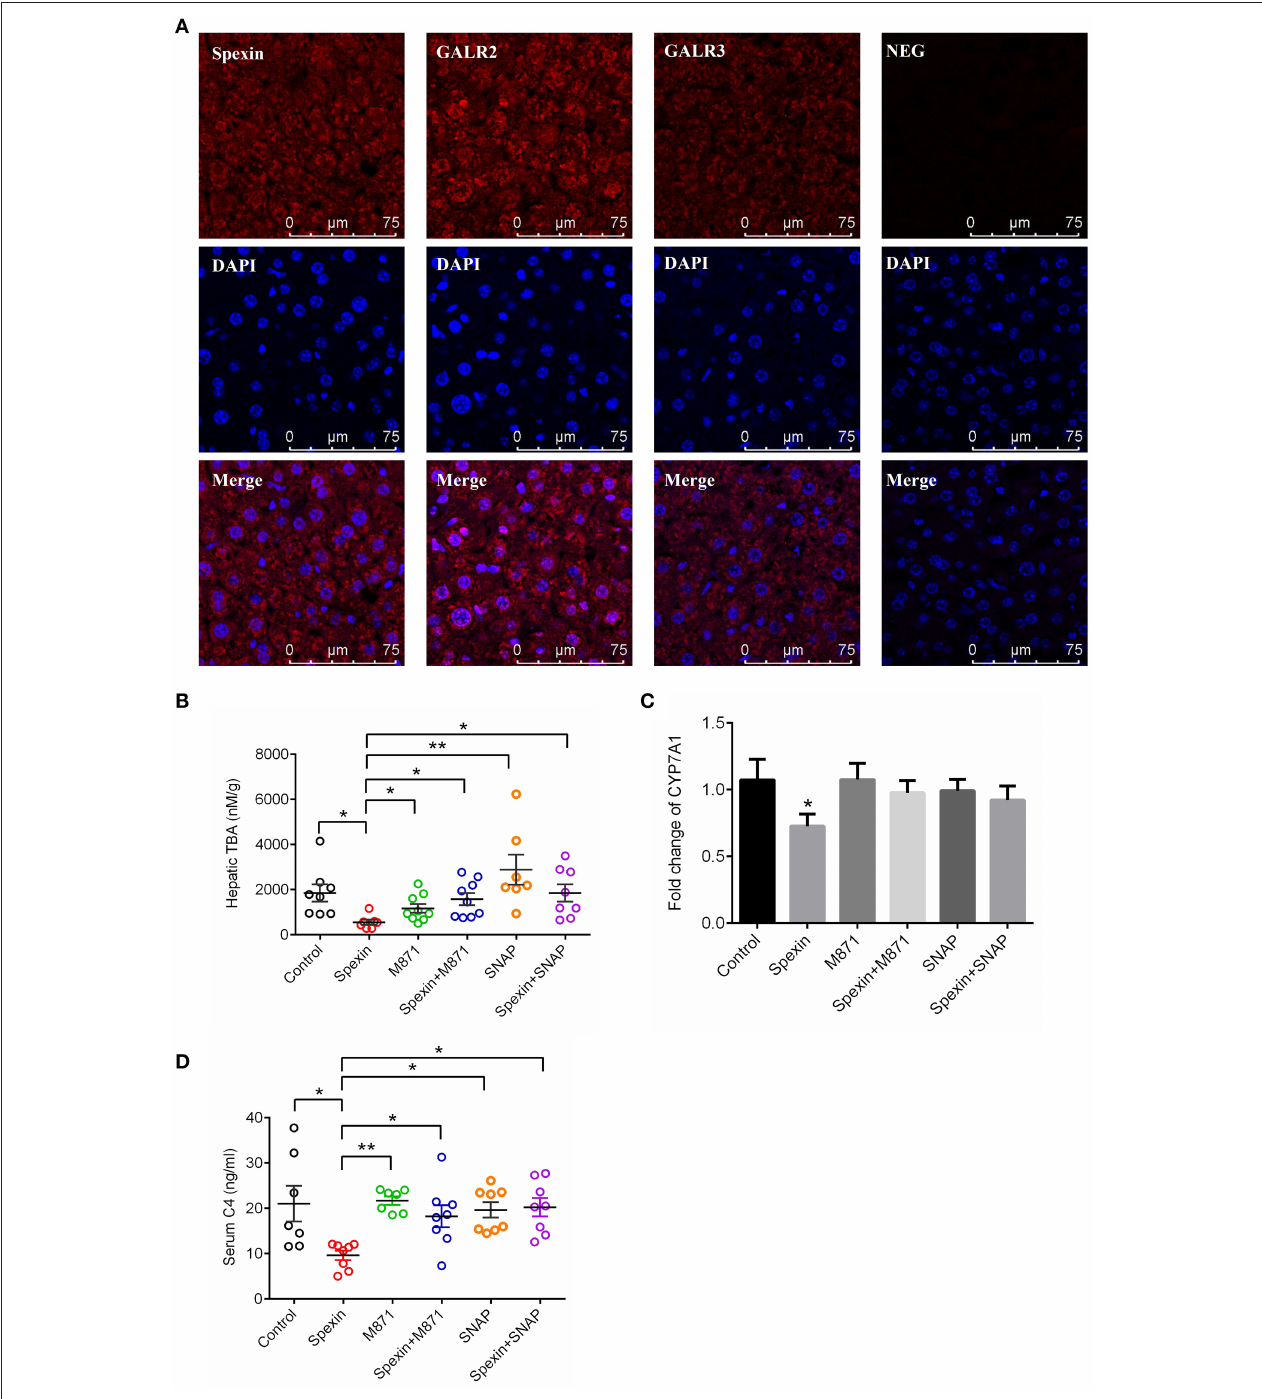
FIGURE 6 | Spexin inhibited bile acid synthesis through GALR2 and GALR3 receptors. (A) Expression of spexin, GALR2 and GALR2 in hepatocytes characterized by confocal imaging. To investigate the role of GALR2/3 in spexin-regulated bile acid synthesis, the mice were i.p. injected with GALR2/3 antagonists 15min before spexin treatment. One hour after drug treatment, serum and liver samples from each mouse were collected for further analysis. Control ( i.p. with saline); Spexin ( i.p. with spexin 300 µ g/kg); M871 ( i.p. with M871 1000 µ g/kg); Spexin + M871 ( i.p. with M871 15 mins before spexin treatment); SNAP37889 ( i.p. with SNAP37889 1 mg/kg); Spexin + SNAP37889 ( i.p. with SNAP37889 15min before spexin treatment). Hepatic level of TBA (B) , hepatic expression of CYP7A1 (C) and serum concentration of C4 (D) were measured as described. Results are shown as Mean ± SEM ( n = 10/group). * p < 0.05 and ** p < 0.01 between different groups resulting from Student’s t